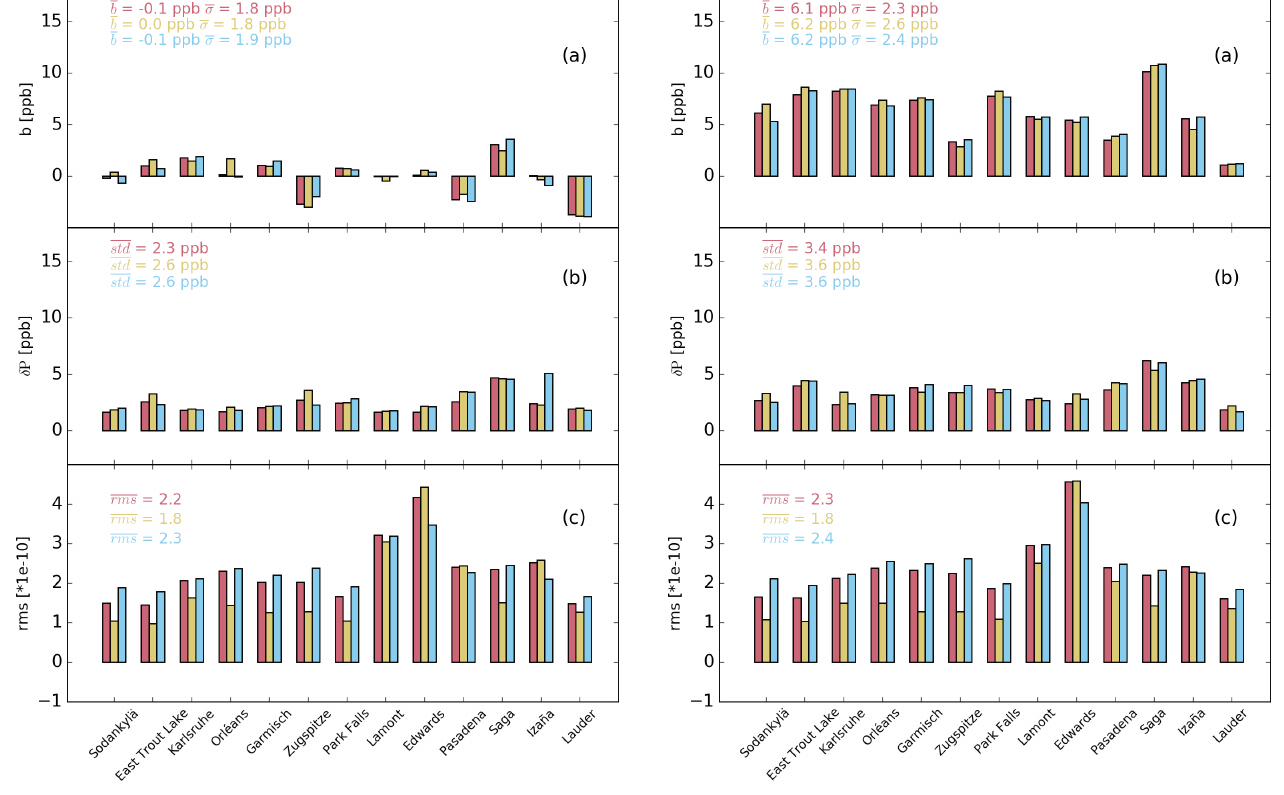
Figure 3. (a) Median bias b j (TROPOMI-TCCON) for differ- ent TCCON sites between colocated daily mean XCO values of TROPOMI and TCCON (see blue and pink dots in Figs. 1 and 2) The global mean bias b and the corresponding standard deriva- tion σ as defined in Eqs. (2) and (3), (b) the scatter δP j of the biases as defined in Eq. (1) with its global mean δP , and (c) the median root-mean-square (rms) of the spectral fit residu- als of the individual retrievals per station and its global mean rms in mols − 1 m − 2 nm − 1 sr − 1 . The figure shows TROPOMI retrievals under clear-sky conditions (yellow), cloudy-sky conditions (blue) and the combination of both (pink). No destriping is applied to the TROPOMI data. The retrieval deploys the spectroscopic database HITRAN 2016 for all absorbers.